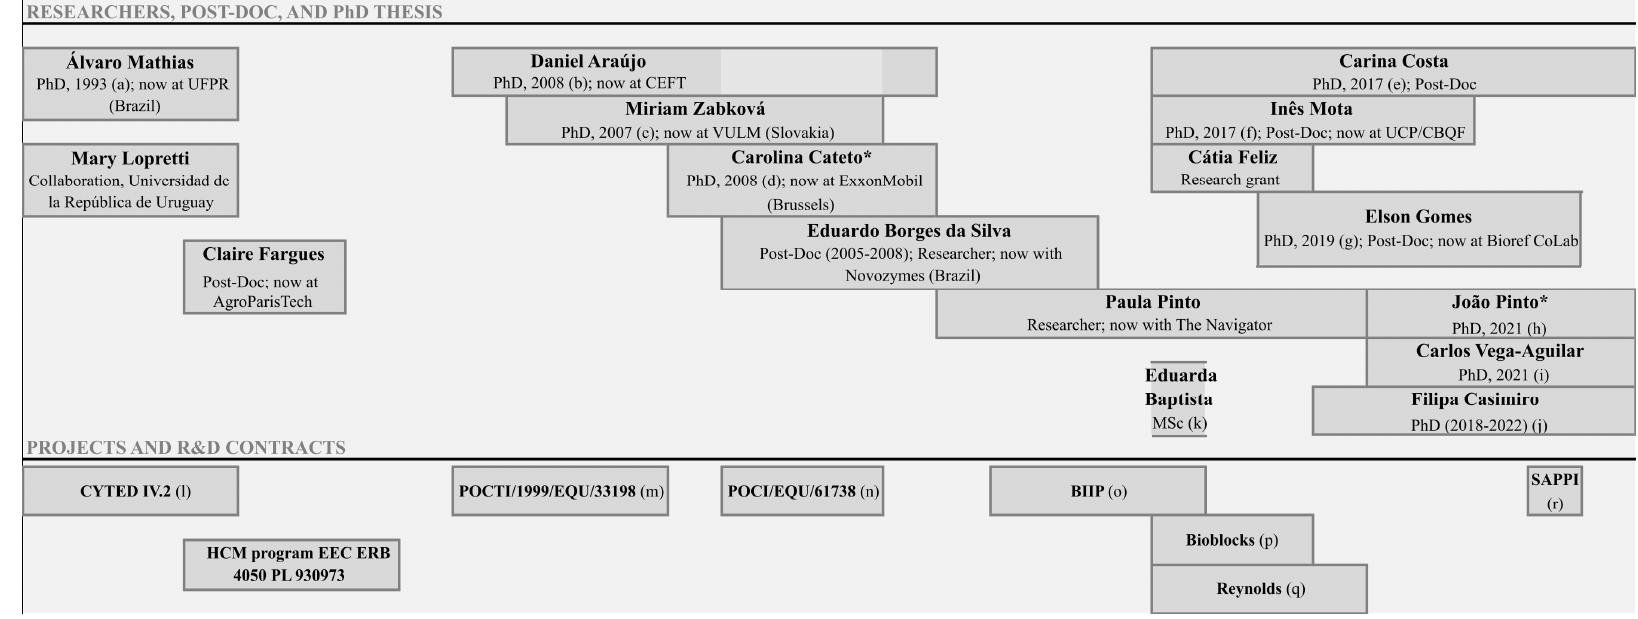
Figure 6. Research in lignin valorization started by Professor Alírio Rodrigues at LSRE (* thesis supervised by Prof. M. Filomena Barreiro (IPB, Portugal)). ( a ) Álvaro Luiz Mathias (UF Paraná, Brazil), “Production of vanillin from kraft lignin: Kinetics and processes”, 1993; ( b ) Daniel Araújo, “Production of vanillin from lignin present in the Kraft black liquor of the pulp and paper industry”, 2008; ( c ) Miriam Zabkova (Slovakia), “Clean technologies for the purification of wastewaters: adsorptive parametric pumping”, 2007; ( d ) Carolina Cateto, “Lignin-based polyurethanes: synthesis, characterization and applications”, 2008; ( e ) Carina Costa, “Vanillin and syringaldehyde from side streams of pulp & paper industries and biorefineries”, 2017; ( f ) Inês Mota, “Fractionation of syringaldehyde and vanillin from oxidation of lignin”, 2017; ( g ) Elson Gomes, “Development of a continuous process for the production of vanillin and syringaldehyde from kraft black liquor”, 2019; ( h ) João Pinto (IPB), “Development of sustainable polymer solutions”, 2019; ( i ) Carlos Alberto Vega-Aguilar (Costa Rica), “Dicarboxylic acids from lignin”, 2021; ( j ) Filipa Casimiro (IPB), “Studies on lignin oxidation and degradation of phenolic products”, 2022; ( k ) Eduarda Baptista, “Ultrafiltração de extrato de casca de Eucalyptus globulus para recuperação de compostos polifenólicos”, 2013; ( l ) CYTED IV.2—“Transformación de lignina en produtos de alto valor agregado”; ( m ) POCTI/1999/EQU/33198—“Development of an integrated process for the production of vanillin from the black liquor of the pulp industry”; ( n ) POCI/EQU/61738/2004—“Purification of vanillin from the lignin oxidation broth”, 2007; ( o ) BIIPP (SI IDT—11551/2010)—“Biorefinaria Integrada na Indústria da Pasta e Papel”; ( p ) BIOBLOCKS—“Concepção de produtos de base biológica como precursores para a bioindústria de síntese química e de biomateriais a partir de fontes lenhocelulósicas”; ( q ) FEUP/RJR/2014/01—Production of Vanillin from tobacco biomass lignin (R. J. Reynolds Tobacco Company, USA); ( r ) Collaboration with SAPPI—“Lignosulphonate’s characterization”, 2020.